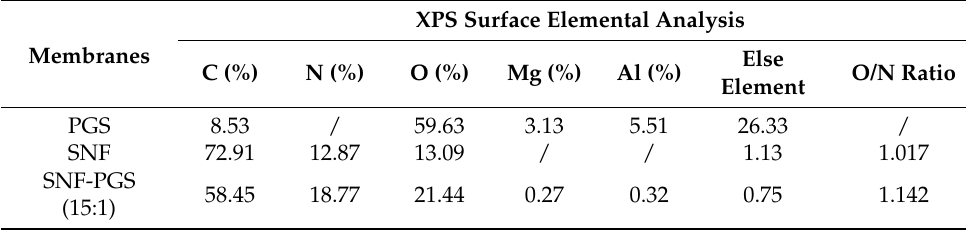
Figure 6. Elemental compositions of membranes: ( a ) XPS patterns of PGS, SNF, and SNF-PGS (15:1) composite membranes; ( b ) SEM-EDS spectrum of SNF-PGS (15:1) composite membranes. Table 1. Elemental compositions and oxygen-to-nitrogen (O/N) ratios of PGS, SNF, and SNF-PGS (15:1) membranes from XPS analysis.